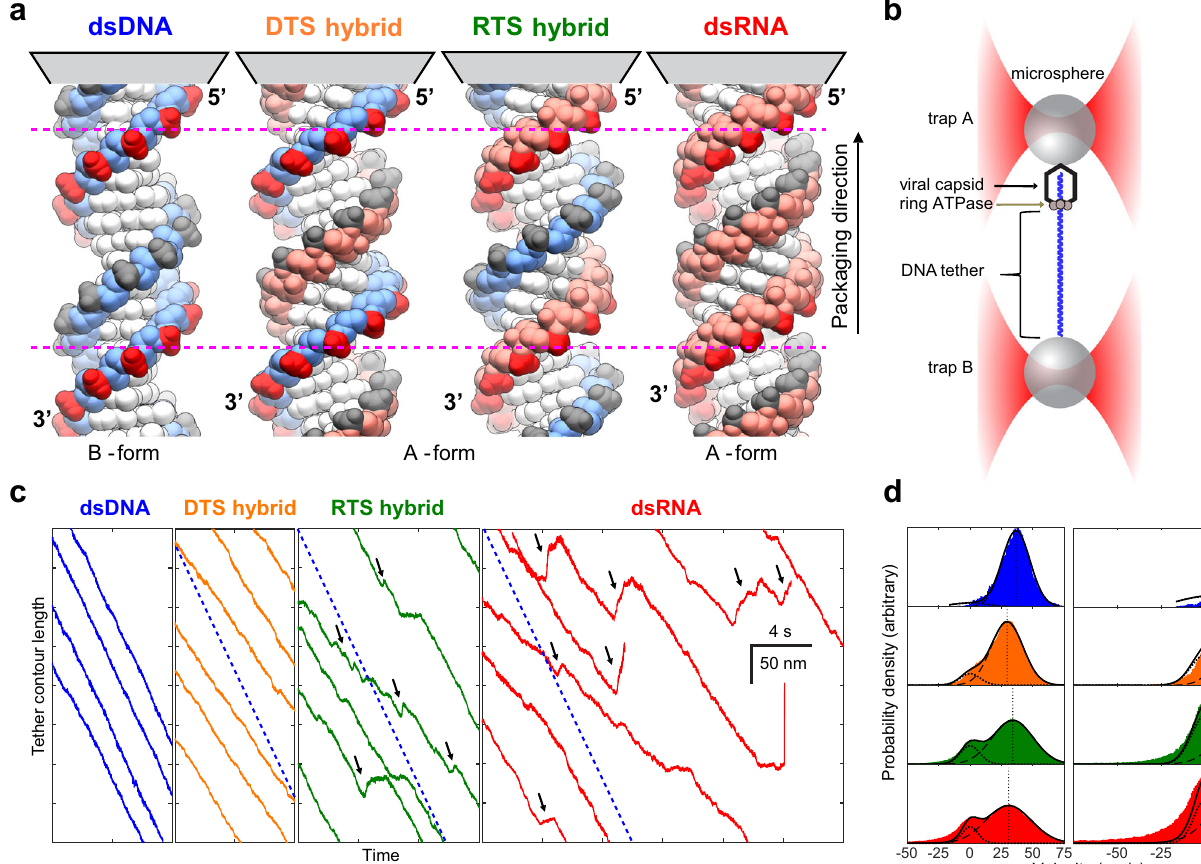
Fig. 1 Packaging of alternative substrates. a The structure of the four substrates is shown, with DNA and RNA strands in light blue and light red, respectively. The strand being packaged from 5 ′ to 3 ′ is designated the tracking strand and its phosphates are colored dark red. Note the differing orientation of the phosphates for DNA and RNA strands, and the differing helical pitches (Table 1, red dotted lines span one pitch of dsDNA). b Single packaging complexes are held between two microspheres using a dual-trap optical tweezer, whereas the tether length is monitored over time. c Representative packaging trajectories for the four substrates are shown at 250 Hz. Dashed blue lines represent the velocity of packaging on dsDNA substrate. Reverse-translocation dynamics are observed on the RTS hybrid and dsRNA (black arrows). d Velocity distributions for the different substrates are curve fi t to the sum of two gaussians (dark line), one with zero mean (curved dotted line) and one with positive mean (curved dashed line), which represent pausing and packaging, respectively. Vertical straight dotted lines mark the mean of the corresponding positive velocity gaussian fi t. The right panel details negative velocities, which correspond to reverse-translocation dynamics. Note the increased probability of these events on dsRNA compared to the RTS hybrid. For all panels, [ATP] is 0.25 mM and opposing force is 7 – 12 pN.